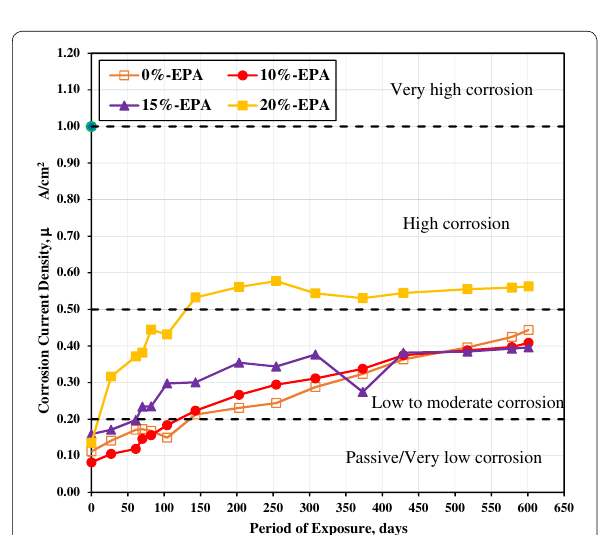
Fig. 14 Corrosion current density on steel embedded in EPA-modified